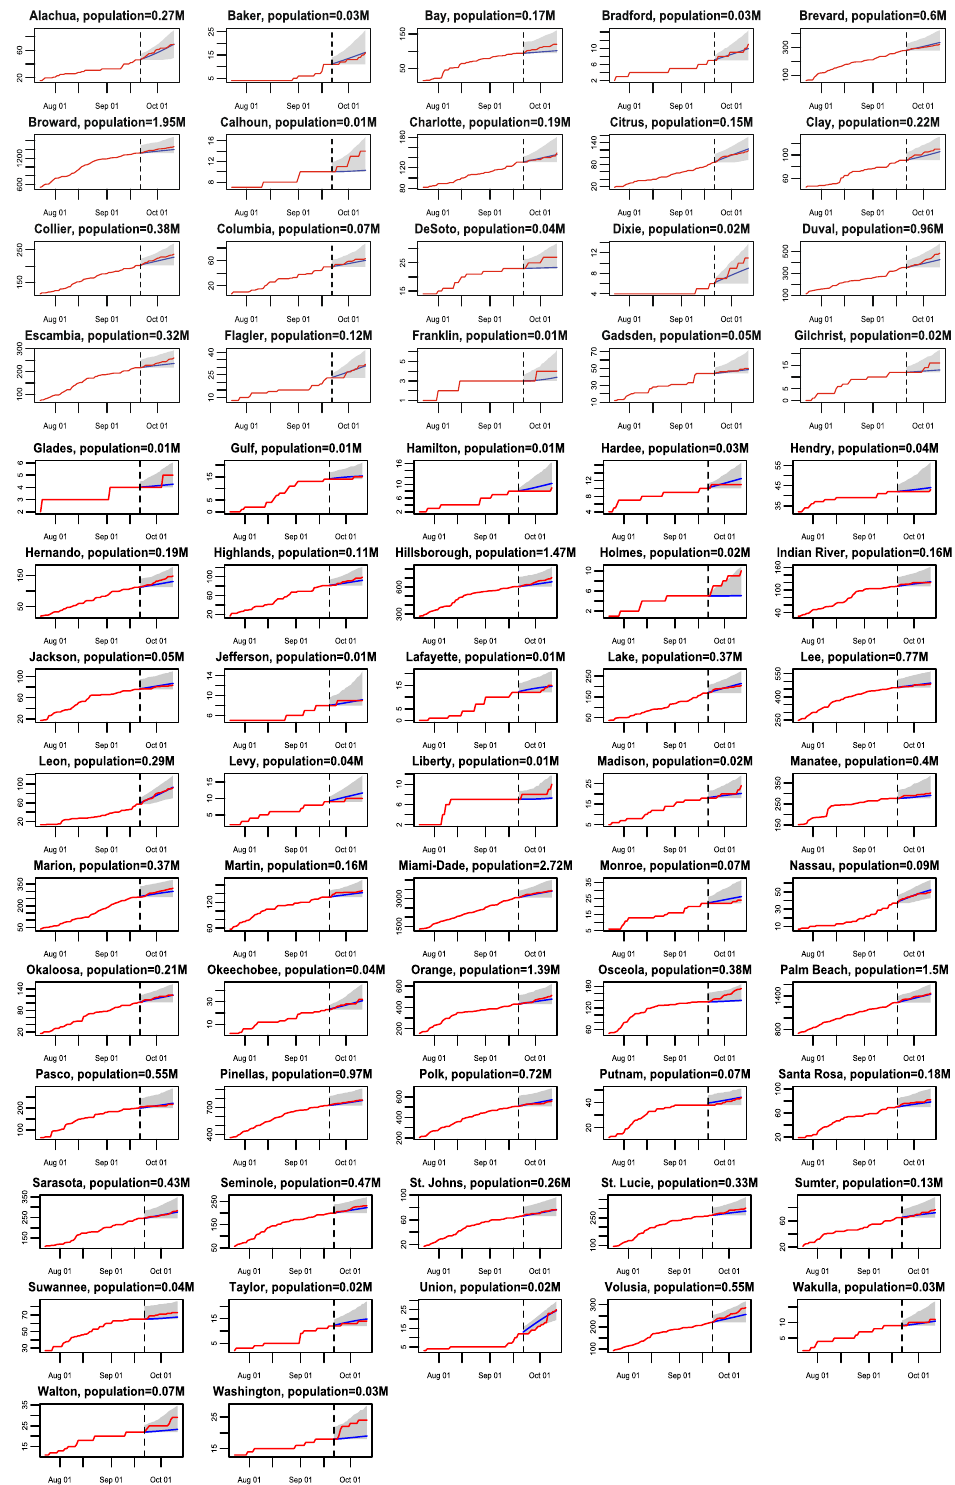
Figure 2. The 21-day forecast in 67 Florida counties with death toll no less than 2 as of 20 September 2020. The training period is from 21 March 2020 to 20 September 2020, whereas the forecast starts from 21 September 2020. The red curves are the cumulative observed death toll from 21 September 2020 to 11 October 2020 and the blue line indicates the forecast for the same period. The shaded area represents the 95% predictive intervals of the forecast for each analyzed county in